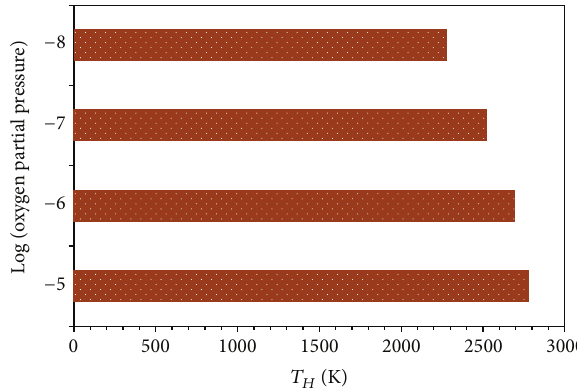
Figure 2: Influence of oxygen partial pressure in the inert flushing gas on 𝑇 𝐻 for Tb-WS